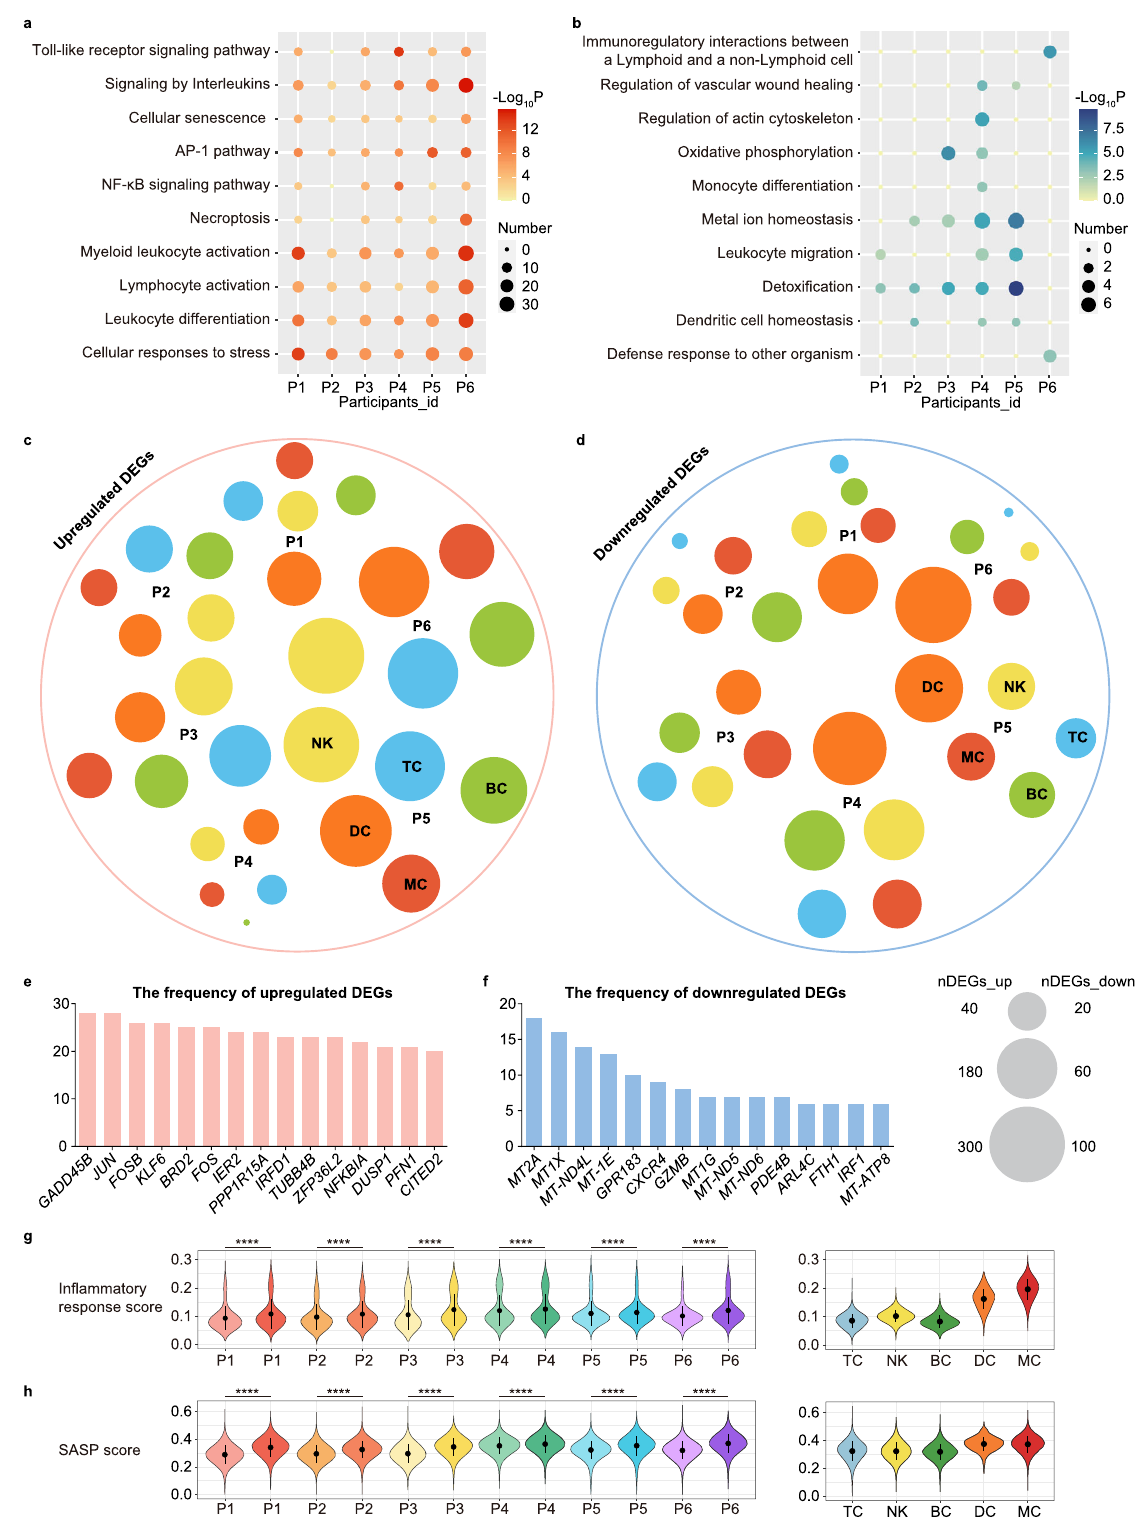
Fig. 2 Changes in transcriptional pro fi les among subjects. Representative GO biological process and pathways enriched in upregulated ( a ) and downregulated ( b ) DEGs based on functional enrichment analysis among subjects. Dot plots showing the distribution of upregulated ( c ) and downregulated DEGs ( d ) in each major cell type of all six participants, the size indicates the numbers of DEGs, and the different colors annotate different cell type. Bar plots showing the frequencies of the top 15 upregulated ( e ) and downregulated ( f ) genes observed across all cell types in six participants. Violin plot of in fl ammatory response score ( g ) and SASP score ( h ) for each sample and immune cell lineage, different participants were represented in different colors, with darker colors representing after SU. For the box plot within each violin plot, middle lines indicate median values, boxes range from the 25th to 75th percentiles. Signi fi cance in g and h was calculated using two-sided Wilcoxon test as implemented in the function “ compare_means ” with default parameters; **** P <